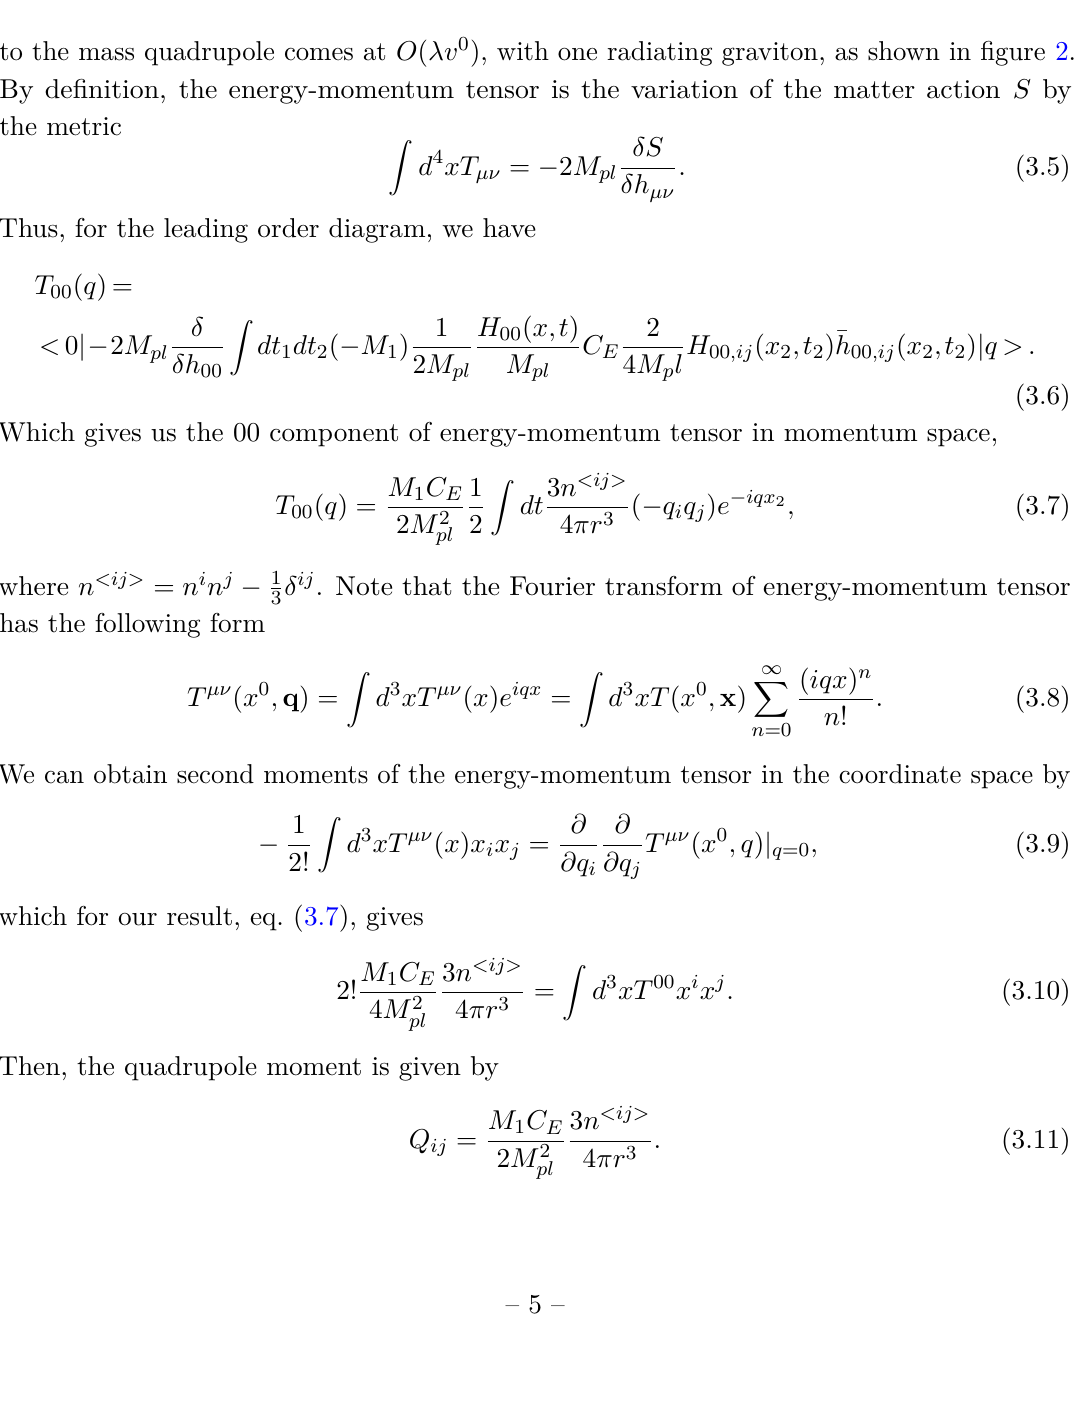
Figure 2 . Leading Order Mass